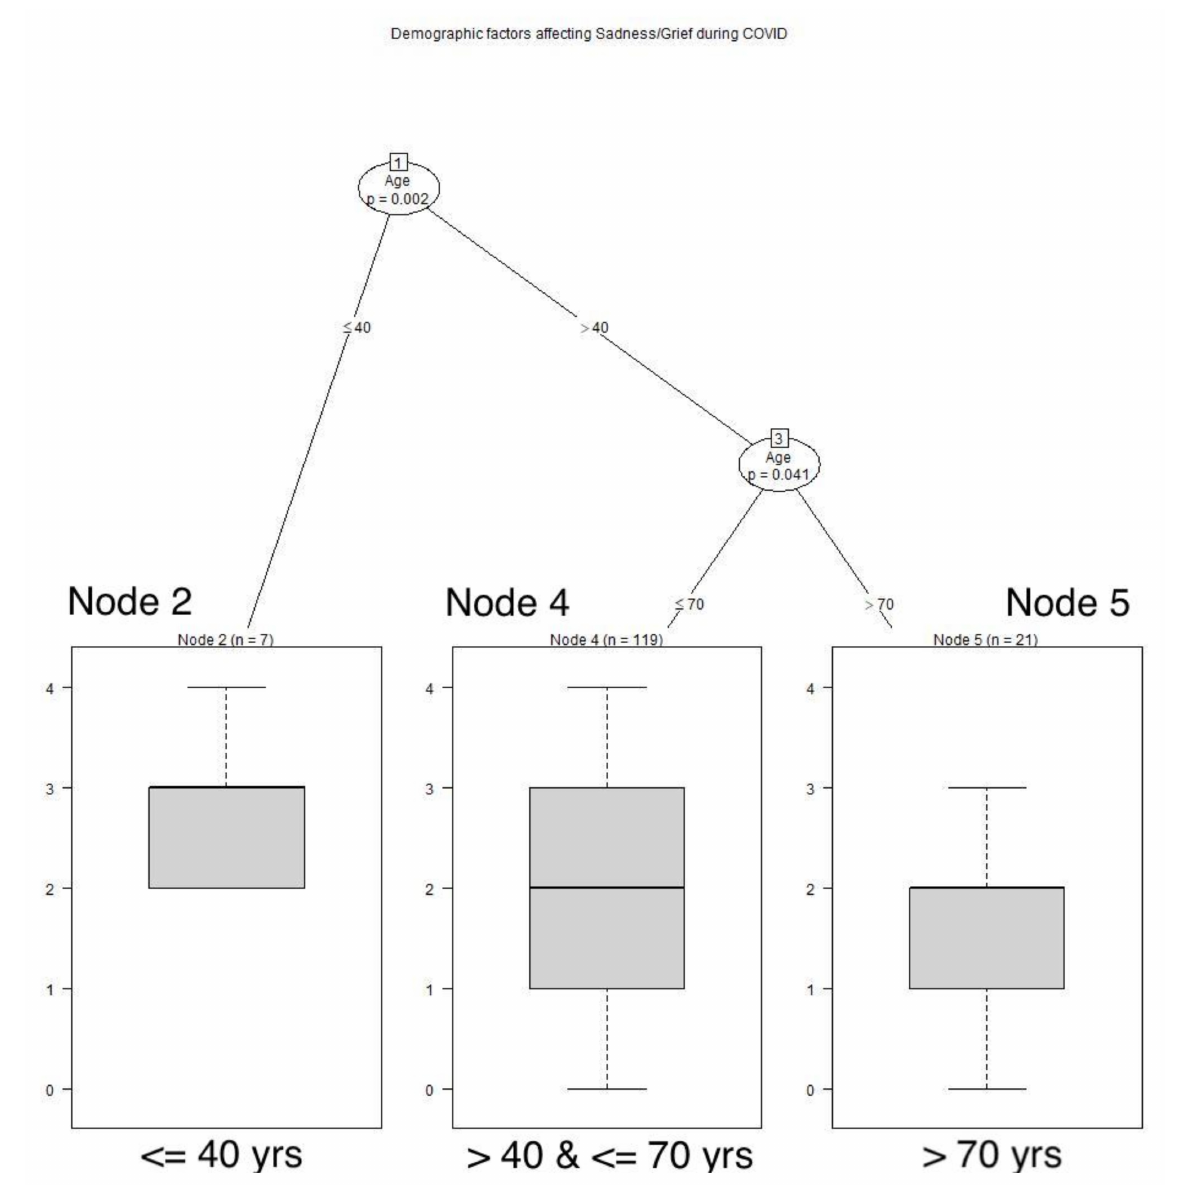
Figure 7. Demographic factors affecting sadness/grief during COVID. Respondents 40 years of age or younger felt sadness/grief more often than those who were older; those over 40 years of age through age 70 were sad or grieving more often than those over 70 years of age: Node 2: x − = 2.714, SD 0.7559; Node 4: x − = 1.832, SD 0.9417; Node 5: x − = 1.429, SD 1.0282. Age also played a role in recollections of human support that respondents recalled receiving during the AIDS pandemic. These respondents over 60 years of age retrospec- tively gave better assessments of their human support during the AIDS pandemic than the younger respondents. Among these younger respondents, gays reported having better support during the AIDS pandemic than straights ( p = 0.019). See Figure 8 TREE . Among these respondents over 60 years of age, those older than 70 years reported significantly better human support than the younger group ( p = 0.043). During COVID, men experienced more adequate human support than women ( p = 0.007). See Figure 9 TREE . Men who had dogs experienced significantly greater human support than those without dogs ( p =